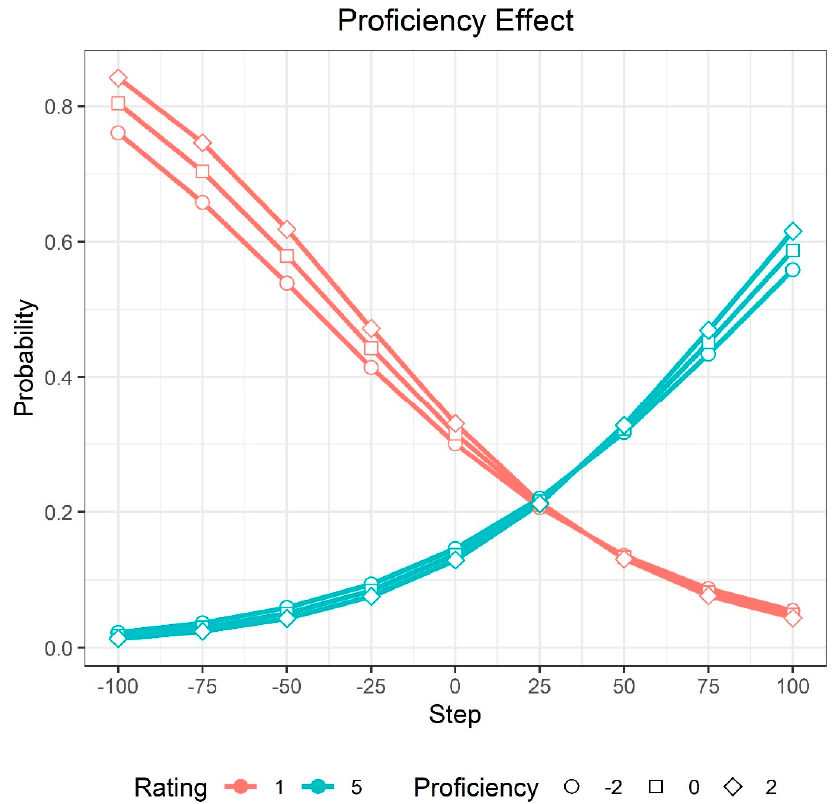
Figure 3. Predicted probabilities of response ratings for voiceless trials as a function of participants’ proficiency in Spanish. Proficiency was standardized, such that 0 = the group average and ± 2 refers to participants 2 SD above and below the mean, which represent the two proficiency extremes in this participant sample. To avoid visual clutter, and because participants tended to choose ratings 1 and 5 much more frequently than the other rating options, only those two probability functions are